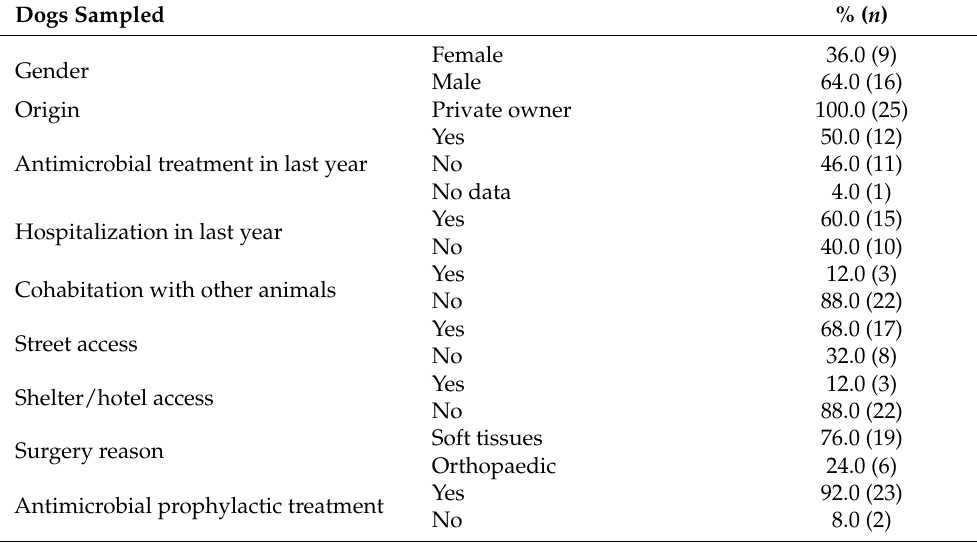
Table 1. Descriptive statistics of healthy dogs sampled ( n = 25) in this